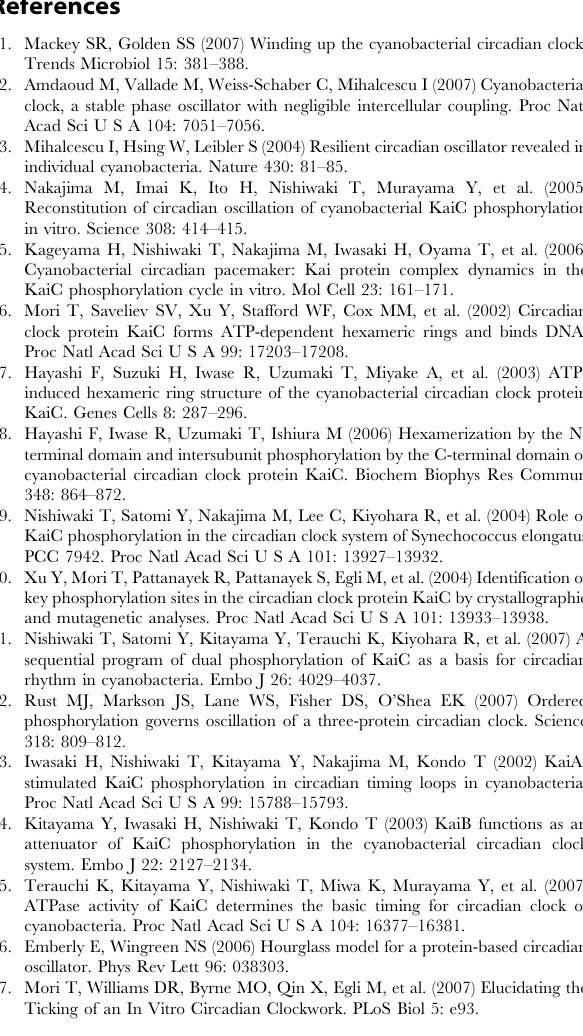
Table S5 Parameters in the estimation of free energies of all reaction and interaction processes in Kai network. Found at: doi:10.1371/journal.pcbi.1000568.s006 (0.12 MB PDF) Video S1 Dynamic node-to-node mass evolution in one complete KaiC phosphorylation cycle. The time for the trough of Y is set to be the zero circadian time. Mass evolution (contour map) in LC (left panel), LBC (right panel) and combined (middle panel) layers are shown. The color bar shown on right corresponds to the fraction of the amount of total KaiC hexamer. Found at: doi:10.1371/journal.pcbi.1000568.s007 (1.16 MB